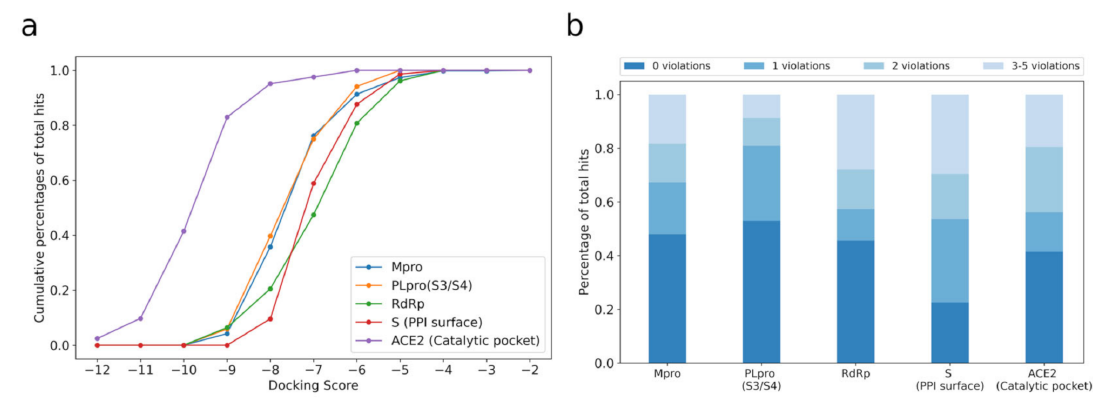
Figure 2. The distribution of docking scores and drug-like properties of CADD recommended compounds. ( a ) The cumulative percentage of CADD recommended compounds with docking scores increasing. ( b ) The percentage of CADD compounds following the Lipinski’s rules. Zero violations indicates the compounds that follow the Lipinski’s “Rule of Five”: MW ≤ 600, HBA ≤ 10, HBD ≤ 5, NrotB ≤ 10, and − 2 ≤ cLogP ≤ 5; 1 and 2 violations indicate the compounds that violate one and two of the above five rules, respectively; 3–5 violations indicate the compounds that violate at least three of the five